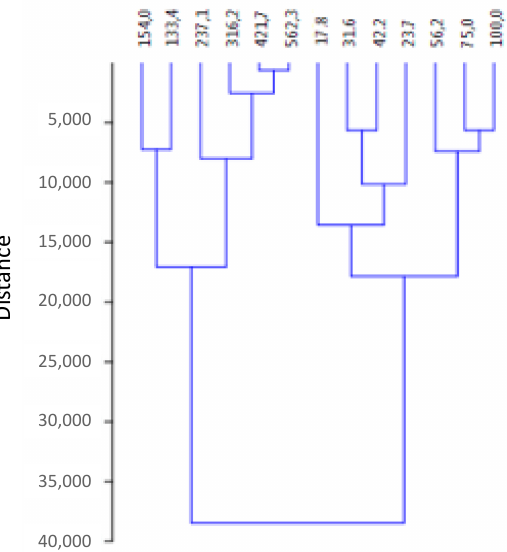
Figure 6. Cluster analysis related to the size fractions of a typical day over all the period.